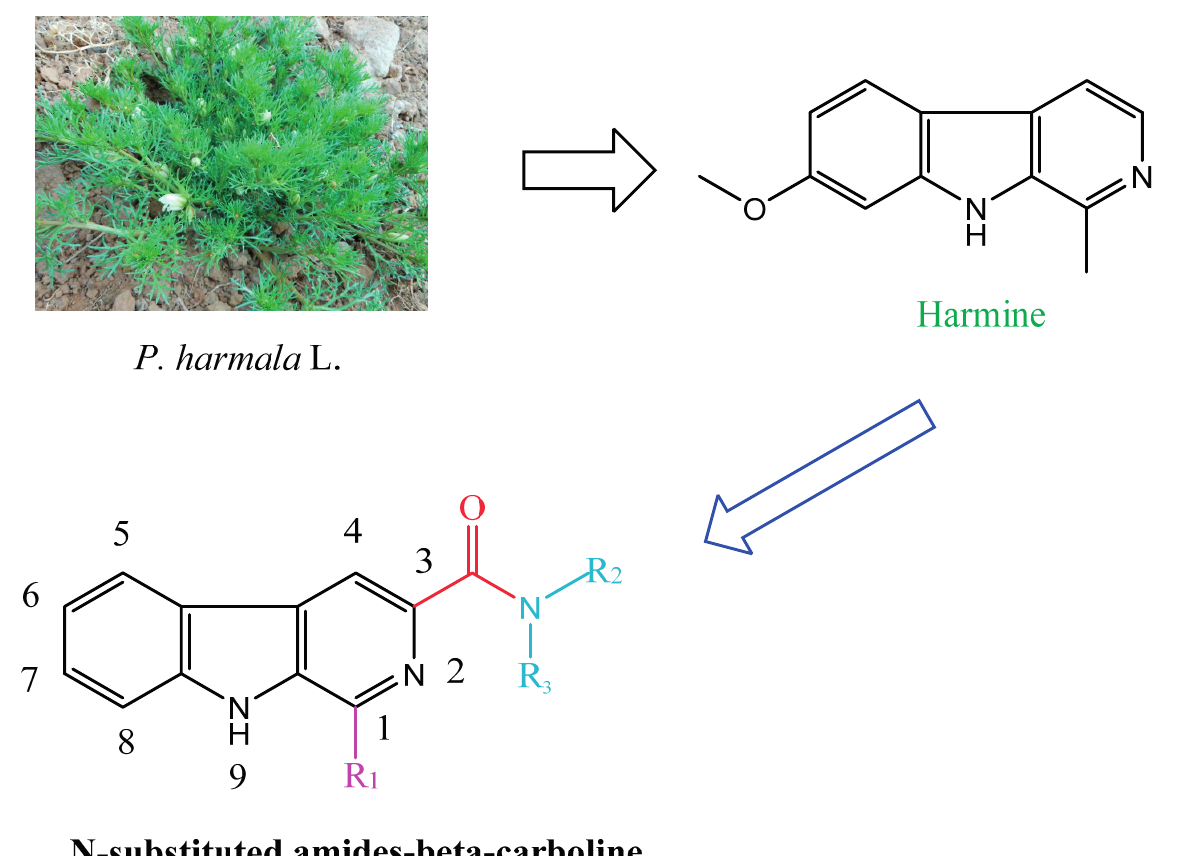
Figure 2. Design of target